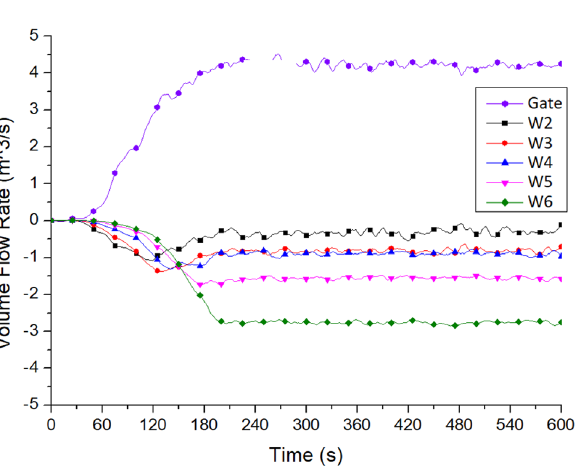
Figure 13. Flowrate variation at the platform windows on each floor of No. 2 staircase (for Case